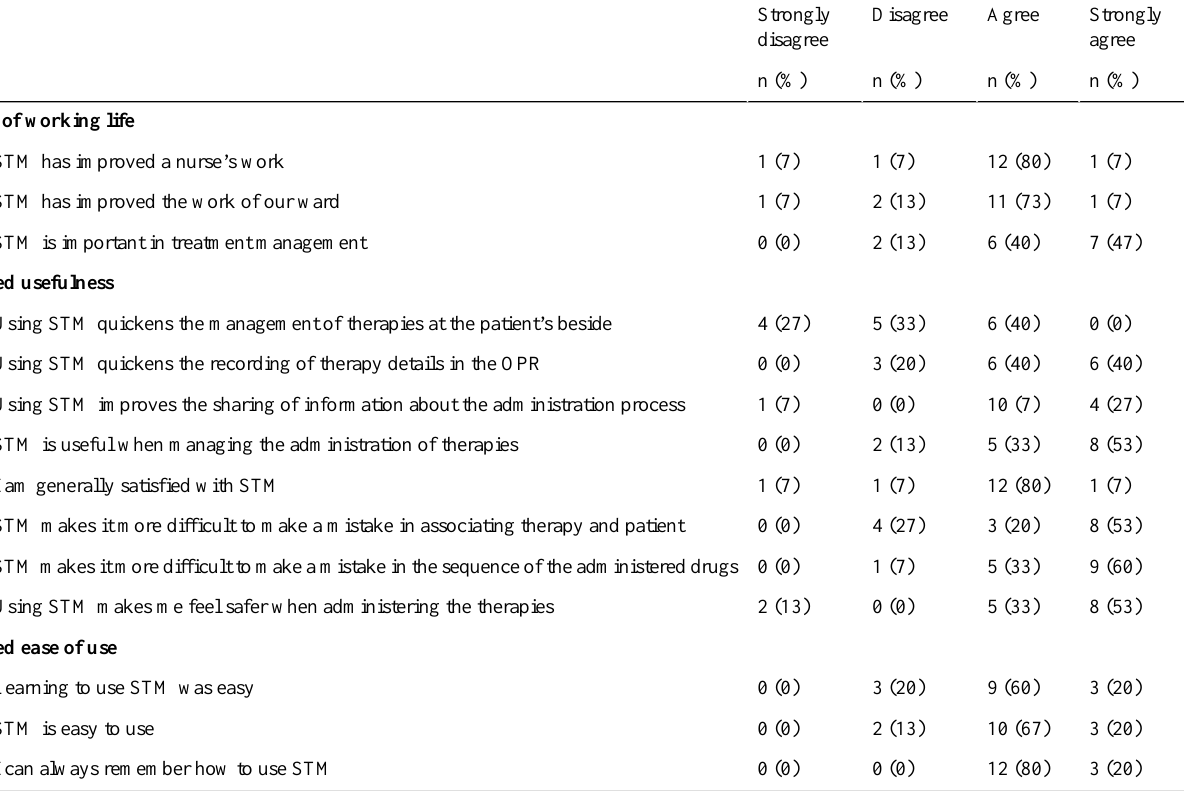
Table 1. Results of the nurses’administered questionnaire on the STM (Safe Therapy Mobile) system (n=15).